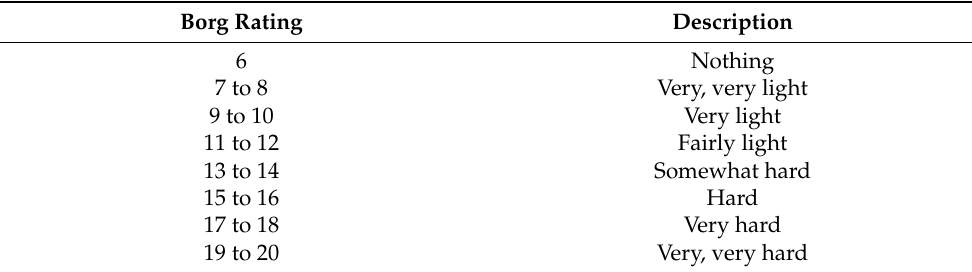
Table 3. The RPE scale and its description.